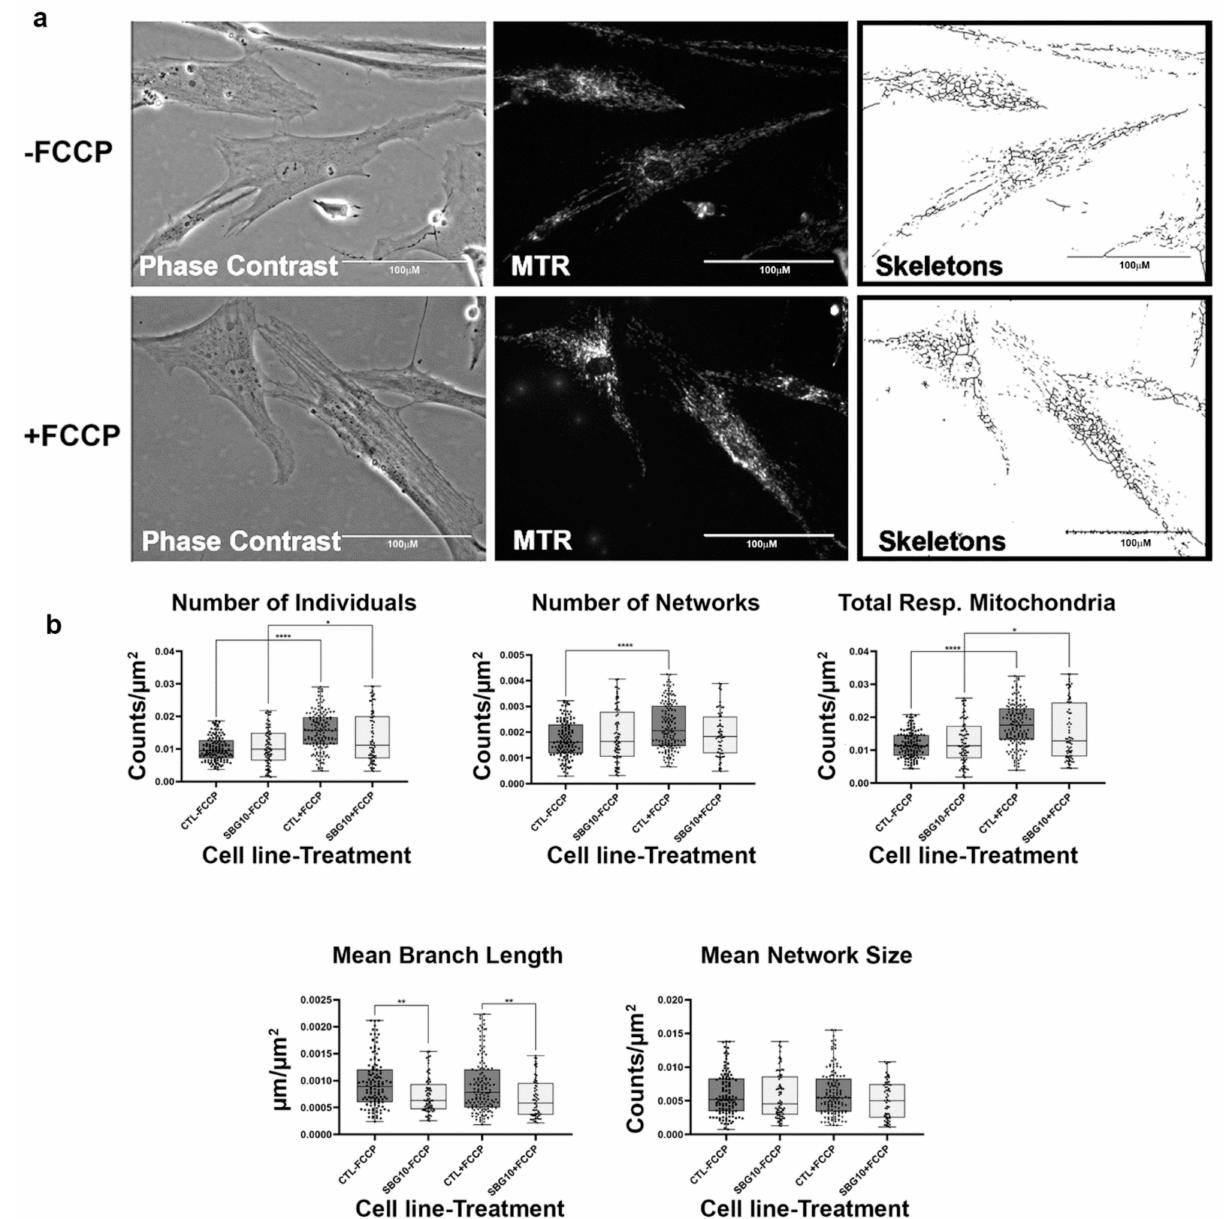
Figure 12. Mitochondrial morphology of SBG10 fibroblast in the absence and presence of FCCP. ( a ) Representative images of SBG10 fibroblast cell lines stained with MTR. The top images are phase contrast, RFP, and skeletonized images of SBG10 fibroblast cell lines without FCCP treatment. The bottom images are phase contrast, RFP, and skeletonized images of SBG10 fibroblasts with FCCP treatment. ( b ) The mean branch length is significantly lower in SBG10 cell lines relative to the healthy control. All data are representative of 10–14 images taken from three independent dishes per treatment group. The bars represent minimum and maximal values, and each black dot represents different data points. **** p < 0.0001, ** p < 0.01, * p < 0.05. Scale bar = 100 µ